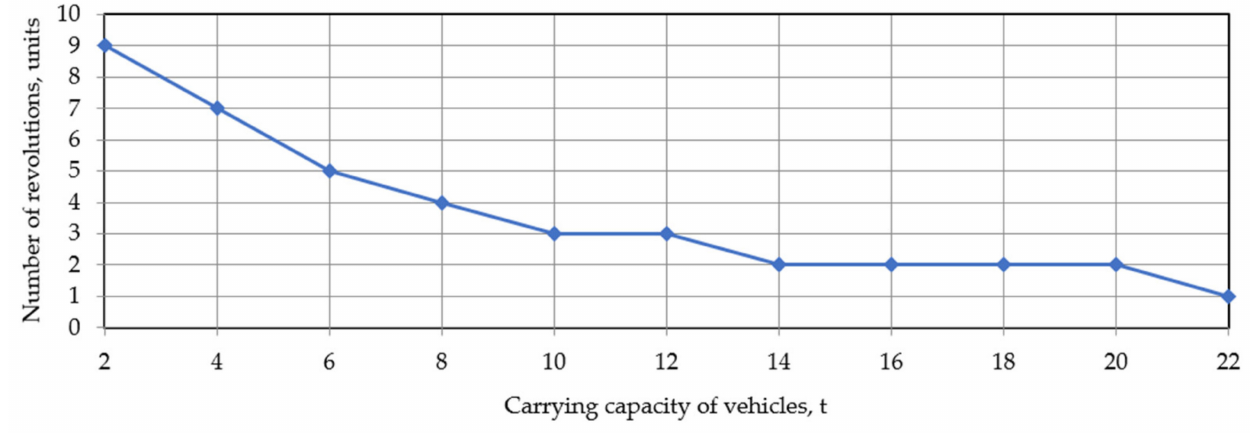
Figure 5. Change in the number of tours depending on the carrying capacity of